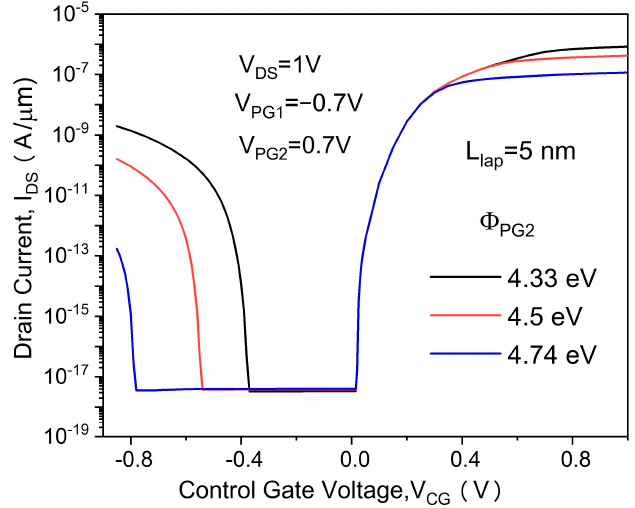
Figure 5. Transfer characteristics of proposed in-built N + pocket ED-TFET with an ED drain for different PG2 working functions.